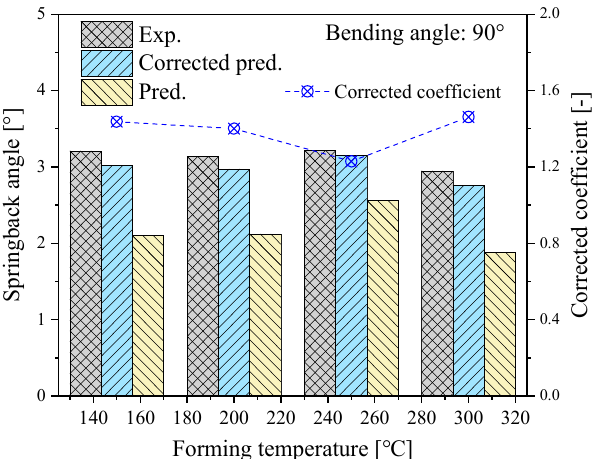
Figure 6. Comparison between predicted and experimental springback angles.